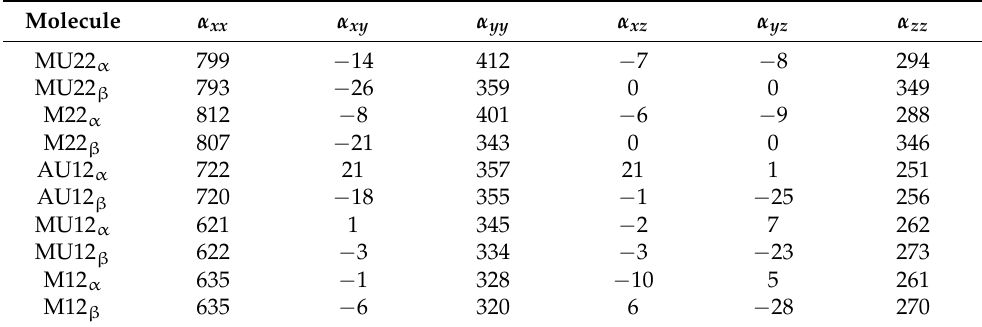
Table 5. Components of the polarizability tensor for the selected conformations of the studied